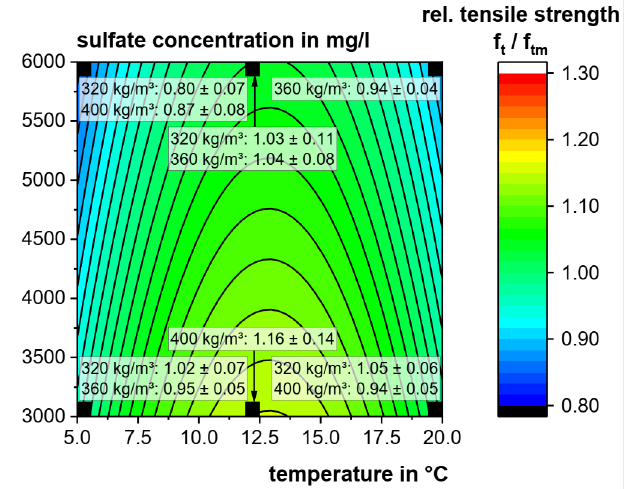
Figure 6. Tensile strength (ref.: maturity function) of concrete with CEM I 42.5 N and w/c = 0.45 after 182 days storage in Na 2 SO 4 solution.